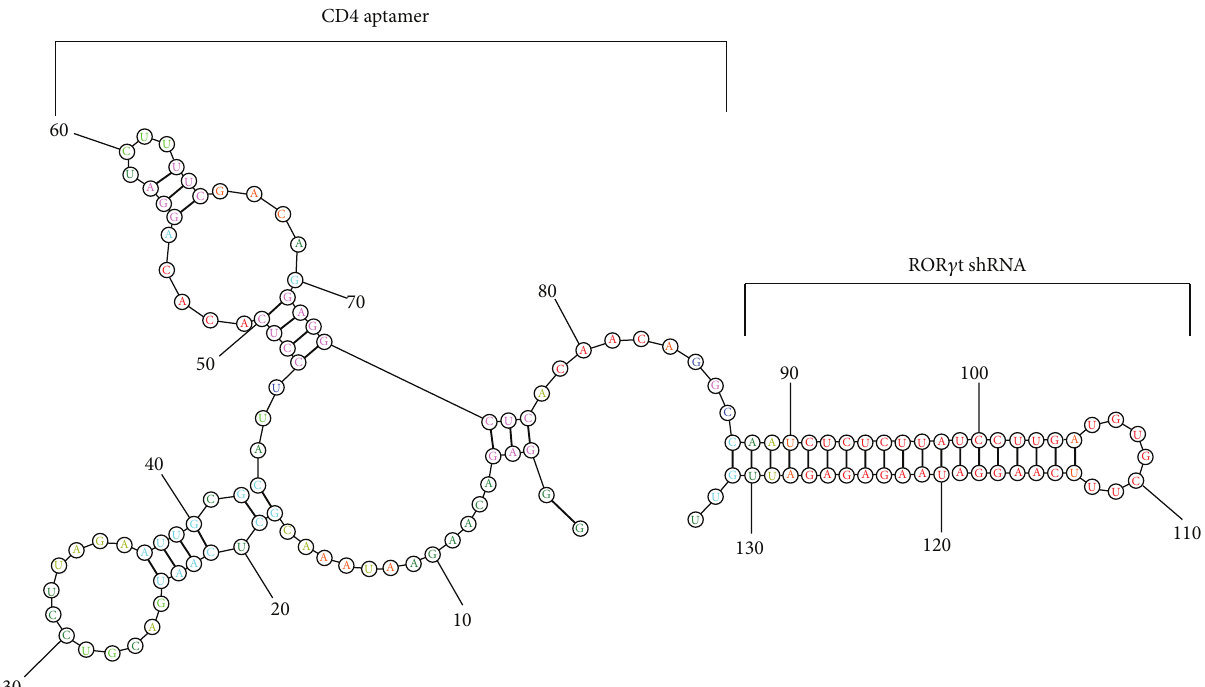
Figure 1: Predicted secondary structure of CD4-aptamer-ROR 𝛾 t shRNA chimera (modified from Song et al., BBRC, 2014, Figure 1(b) [104] with